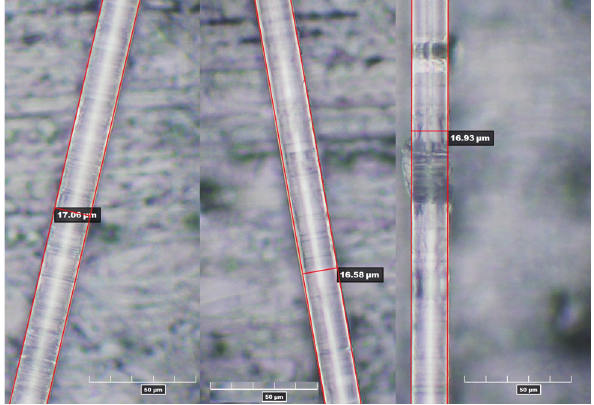
Figure 6: Digital microscope images of R-glass fibers from left to right: untreated; after 69 h in water at 60°C; after 3194 h in water at 60°C.